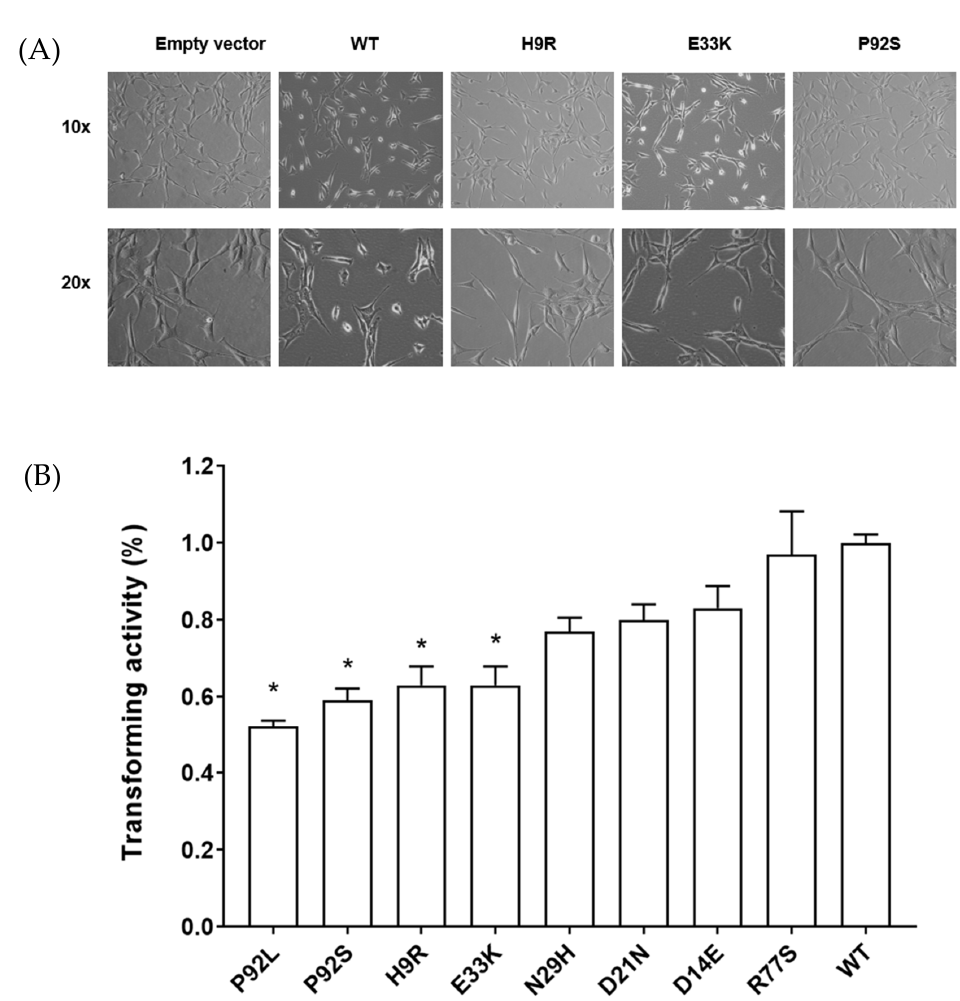
Figure 3. Morphology and anchorage-independent growth of NIH3T3 transfected with HPV16 E7 WT and variant types. ( A ). Morphology of NIH3T3 cells stably expressing empty vector, WT and the indicated variant types. Morphology of stable NIH3T3 cells (10x, 20x). ( B ). Quantitation of anchorage- independent cell growth of HPV16 E7 variants on soft agar and each variant was compared to WT that cell growth was adjusted to 100%. *, p < 0.05 for comparison with WT